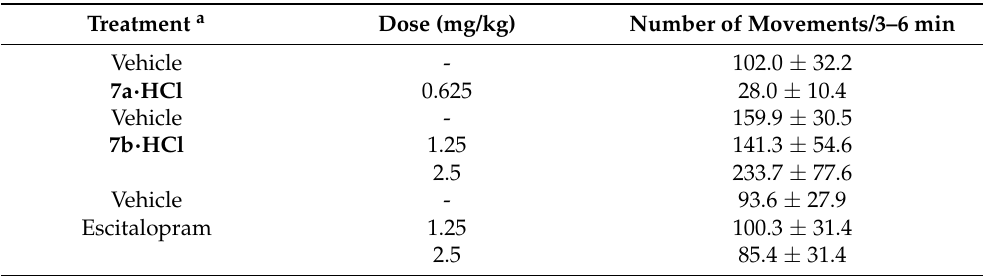
Table 3. Influence of compounds 7a·HCl , 7b·HCl and escitalopram on spontaneous locomotor activity in mice.